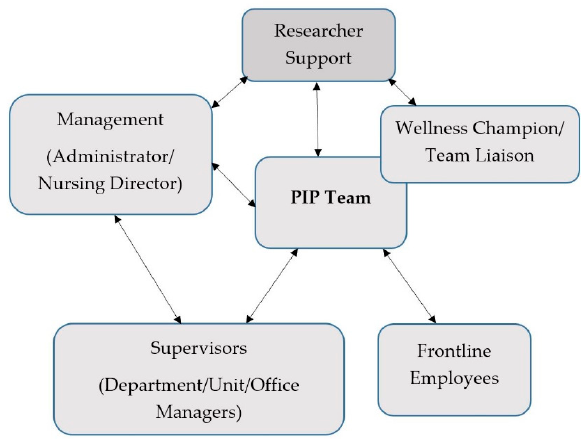
Figure 2. Participatory Intervention Design within Centers.